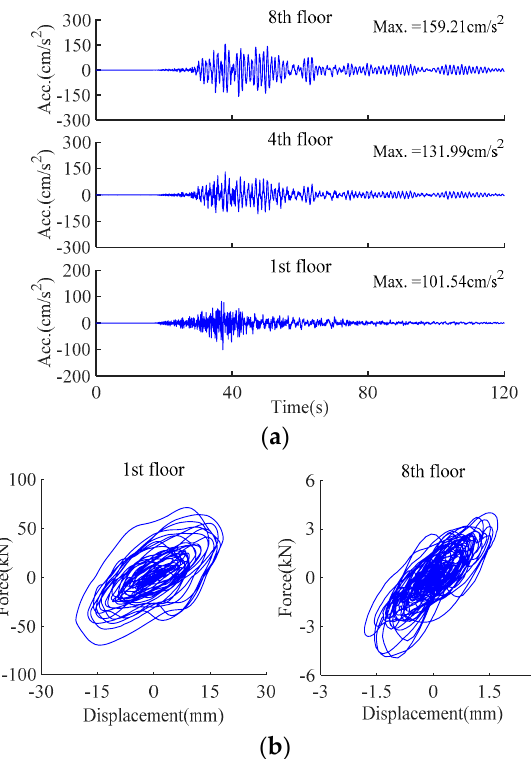
Figure 3. A typical set of earthquake measurements of the building: ( a ) Accelerations of monitored floors; ( b ) Force and displacement of monitored oil dampers.